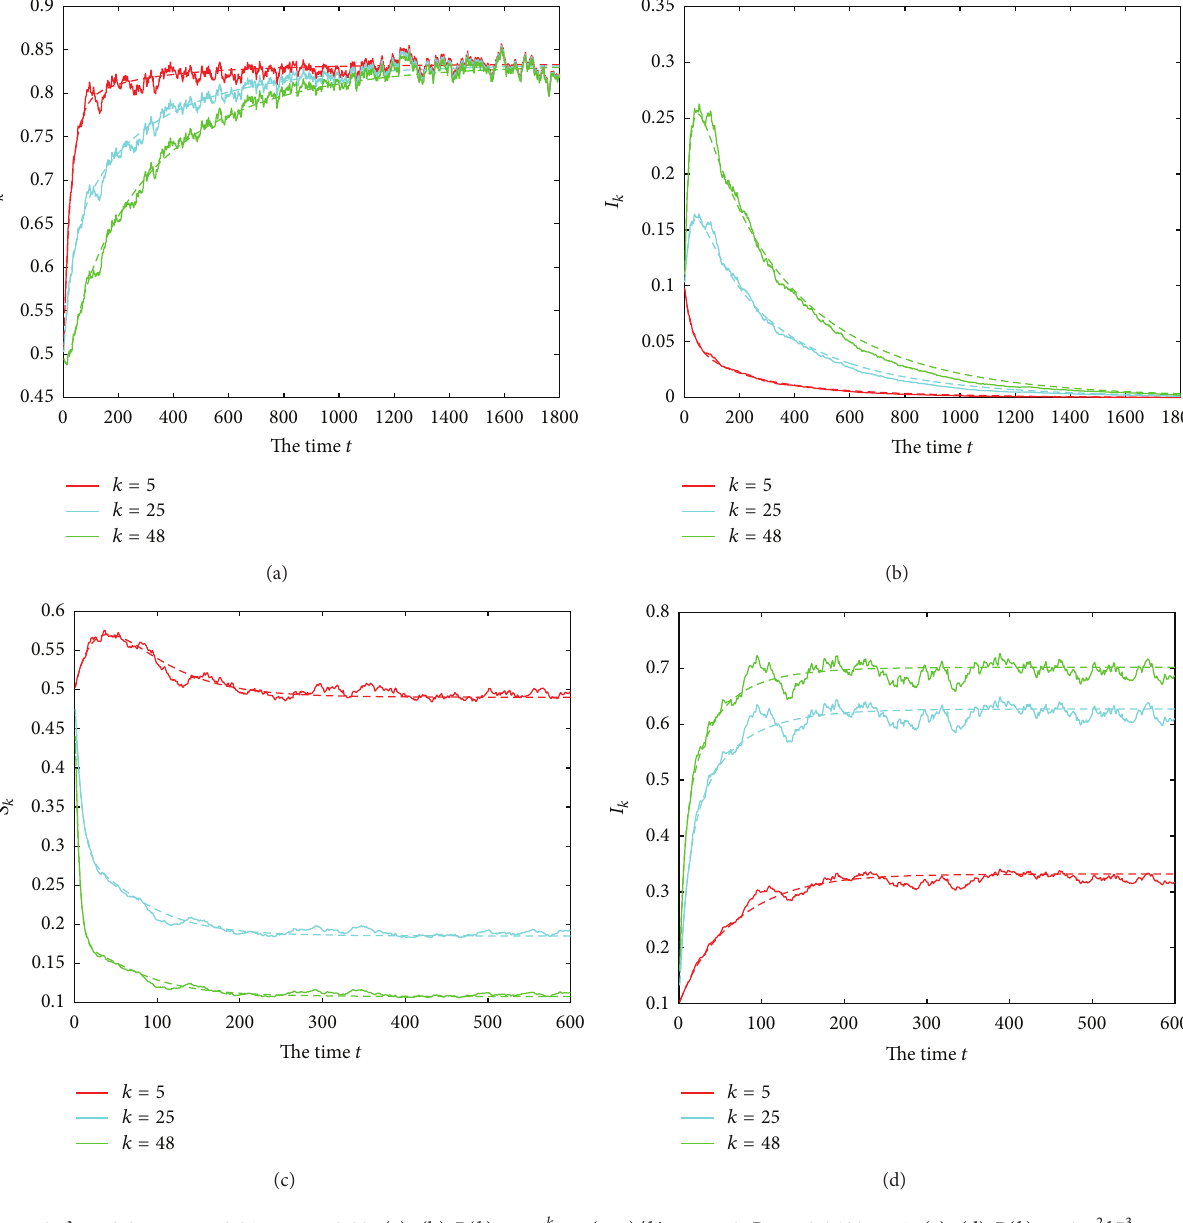
Figure 2: 𝜆 = 0.05 , 𝜎 𝑘1 = 0.01 , 𝜎 𝑘2 = 0.02 . (a), (b) 𝑃(𝑘) = 𝑚 𝑘 exp (−𝑚)/𝑘! , 𝑚 = 6 , 𝑅 0 = 0.9409 ≤ 1 ; (c), (d) 𝑃(𝑘) = 2𝑚 2 𝑘 −3 , 𝑚 = 3 , = 1.8142 ≥ 1 𝑅 0